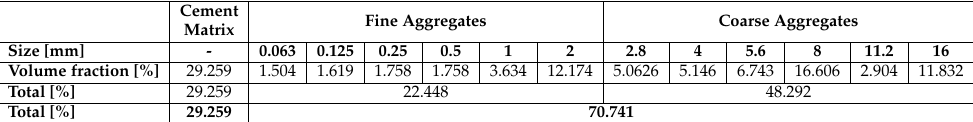
Table 2. Experimental quantification of the concrete compositions according to standard AB16. Cement